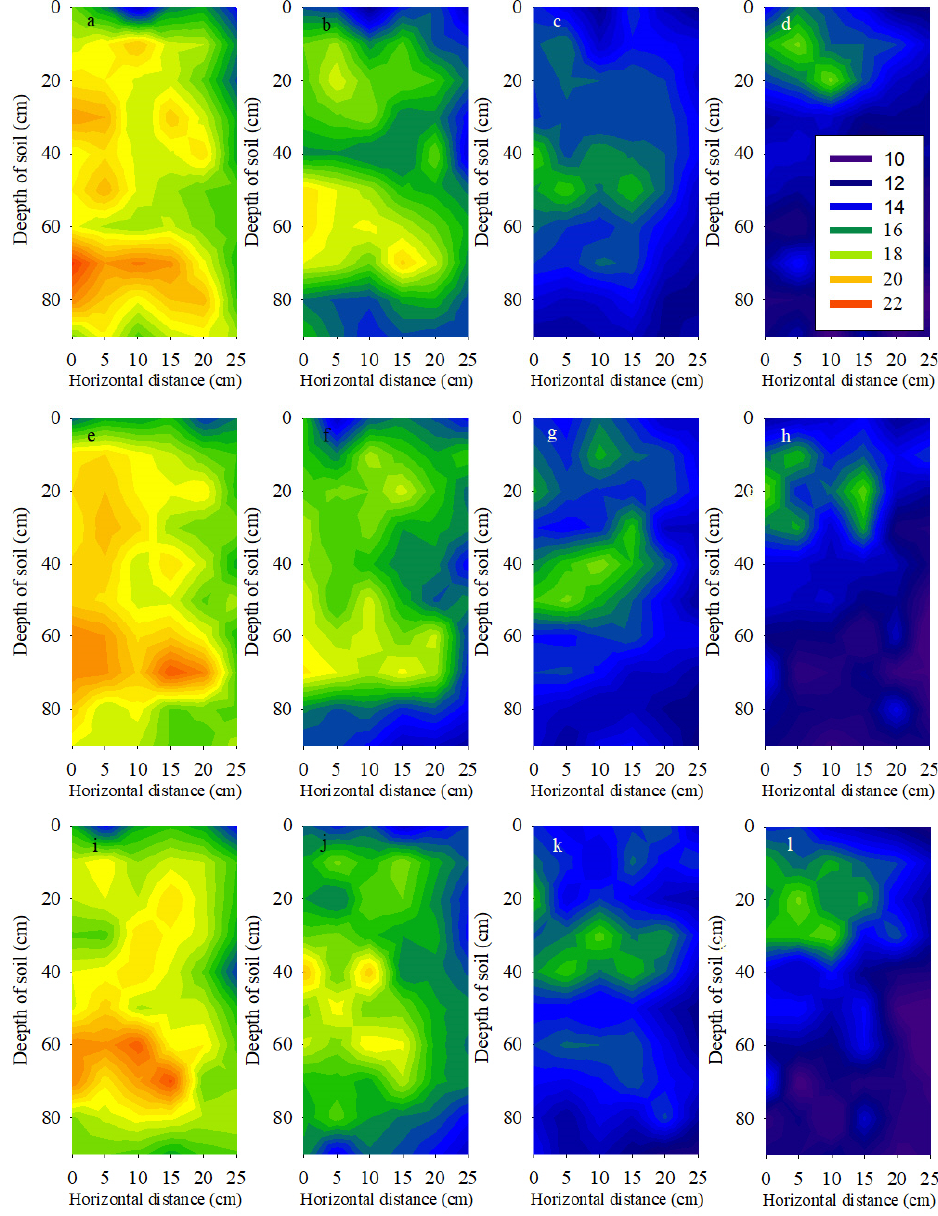
Figure 2. E ff ects of di ff erent water and fertilizer treatments on soil water content of young apple trees. The soil water content was measured using the gravimetric method, the depth interval spacing was 10 cm (from 0 to 90 cm) and the horizontal interval spacing was 5 cm (from 0 to 25 cm). a , b , c , d = F1 (W1,W2,W3,W4); e , f , g , h = F2 (W1,W2,W3,W4); i , j , k , l = F3 (W1,W2,W3,W4).